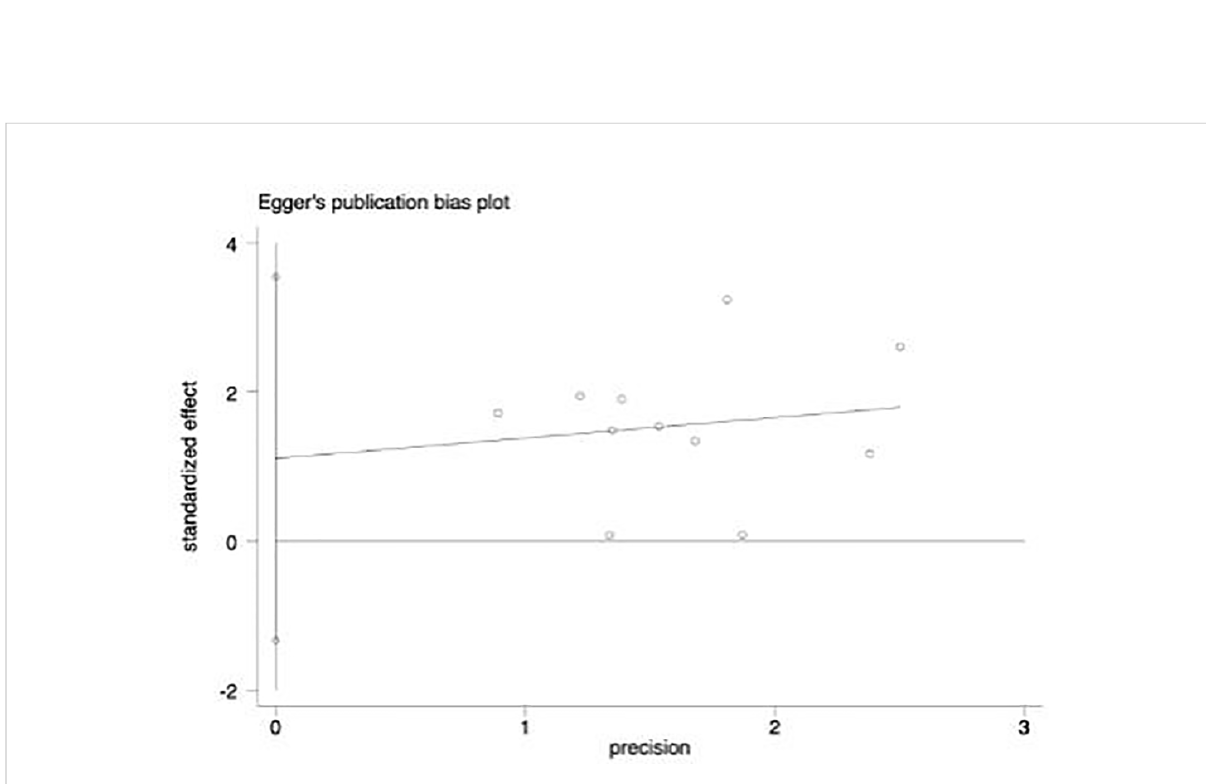
FIGURE 10 Egger fi gure. The circles in the fi gure represent the included articles. It is found in the fi gure that the included articles are approximately lineardistribution, so there is no